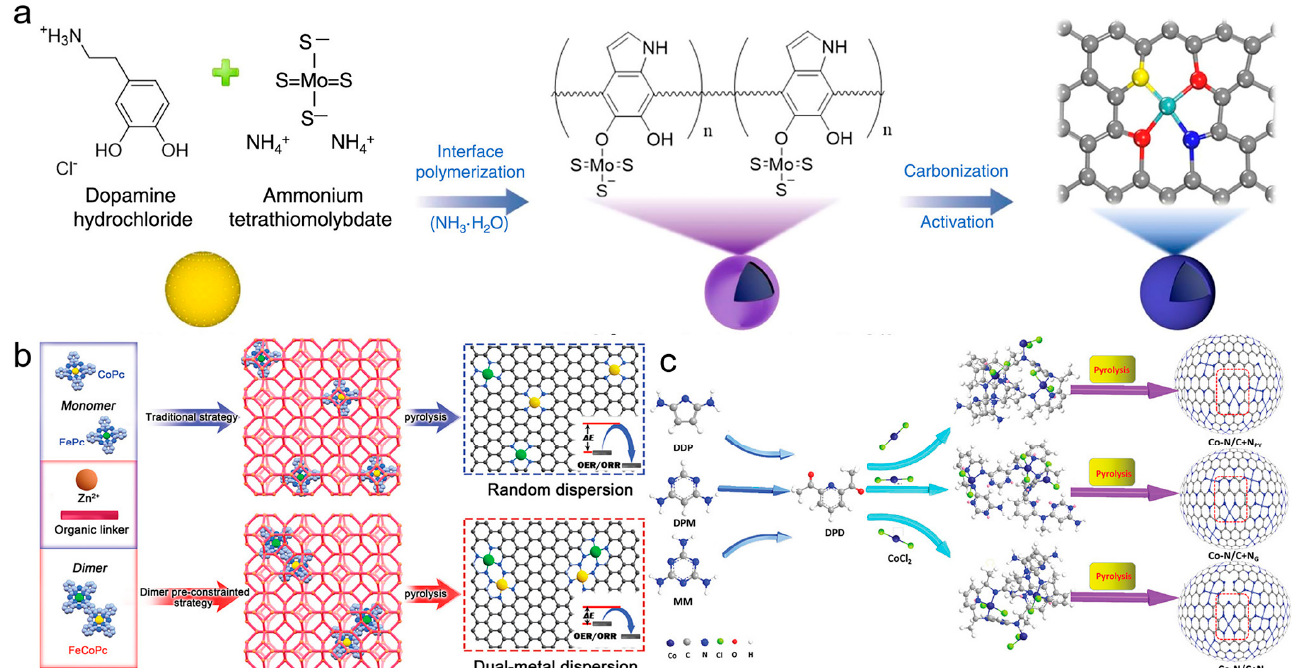
Figure 10. ( a ) Preparation process of Mo single-atom catalyst with N, O, and S coordination atoms. Reproduced with permission of [102], copyright 2022 Elsevier. ( b ) Schematic diagram of the fabricating of Co–Fe dual–metal–atom center catalyst. Reproduced with permission of [103], copyright 2022 John Wiley and Son. ( c ) Illustration of the synthesis process of Co single-atom catalysts coordinated with different types of N heteroatom. Reproduced with permission of [105], copyright 2022 John Wiley and Son.